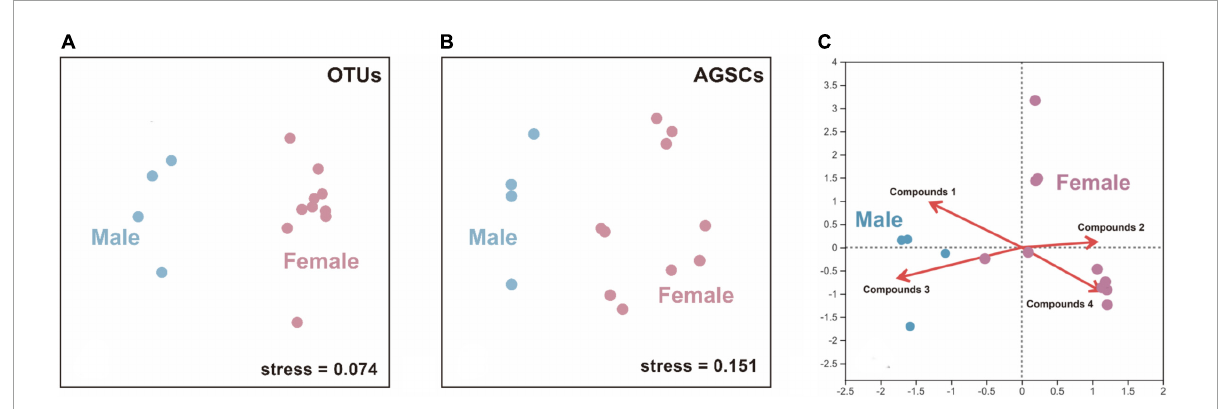
FIGURE3 The differences and correlation between male and female estrus pandas in the microflora (OTUs) and anogenital gland secretion compounds (AGSCs). (A) A non-metric multidimensional scaling (nMDS) plot showing a difference in structure (Bray–Curtis index) between the AGS bacterial communities of adult male and female giant pandas in estrus ( n = 14). (B) An nMDS plot showing a difference in structure between the AGSCs profiles of adult male and female giant pandas in estrus ( n = 14). (C) A canonical correlation analysis (CCA) plot showing a correlation to the AGS compounds and AGS bacterial communities of different sex. ( n = 14). Compounds 1–4 represent: (E)-9-octadecenoic acid ethyl ester, cholestane-3-ol, dibutyl phthalate and 2-isopropyl-5-methyl-1-heptanol,